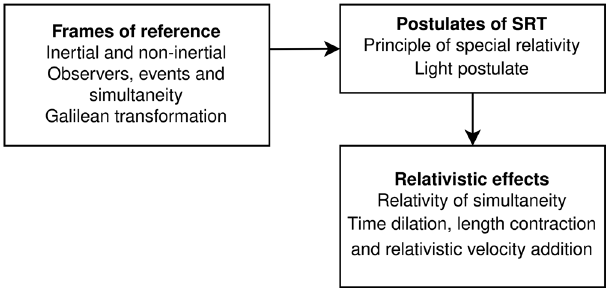
FIG. 2. A schematic representation of students ’ learning pro- gression in a typical introductory course on SRT.